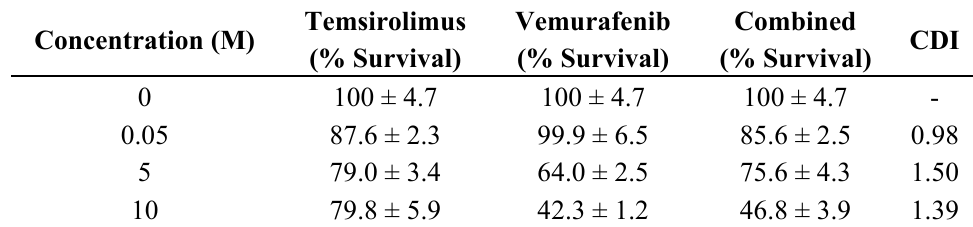
Table 2. Tumor cell survival after treatment of H3 melanoma brain metastasis cells. CDI, coefficient of drug